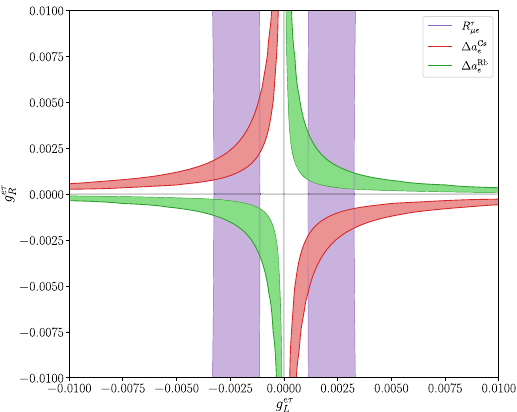
Fig. 6 Constraints on g e τ couplings and prospects for ( g − 2 ) e : the L , R red and the green regions respectively denote the 1 σ ( g − 2 ) Cs e and ( g − 2 ) Rb e favoured regimes. On the left, allowed regions in the same-